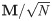
Spectrum of the matrix M/N for inhibitory population rate model with g(x) = ϕ(x).The matrix was diagonalized numerically for N = 10000, K = 400, I
0 = 1 and different values of J
0. A: The bulk of the spectrum for J
0 = 6 (blue) and for J
0 = 1.12 (red). Left: The imaginary parts of the eigenvalues are plotted vs. their real parts for one realization of M. This indicates that the support of the spectrum is a disk of radius λ
max. Right: Histograms of N
eig/R (one realization of M) where N
eig is the number of eigenvalues with a modulus between R and R+ΔR (ΔR = 0.0428 (top), 0.0093 (bottom)) for J
0 = 6 (top) and J
0 = 1.12 (bottom). The distribution of eigenvalues is uniform throughout the spectrum support. B: The largest real part of the eigenvalues (black dots), λ
max, is compared with the conjecture, Eq (7) (solid line). The fixed point loses stability when λ
max crosses 1.